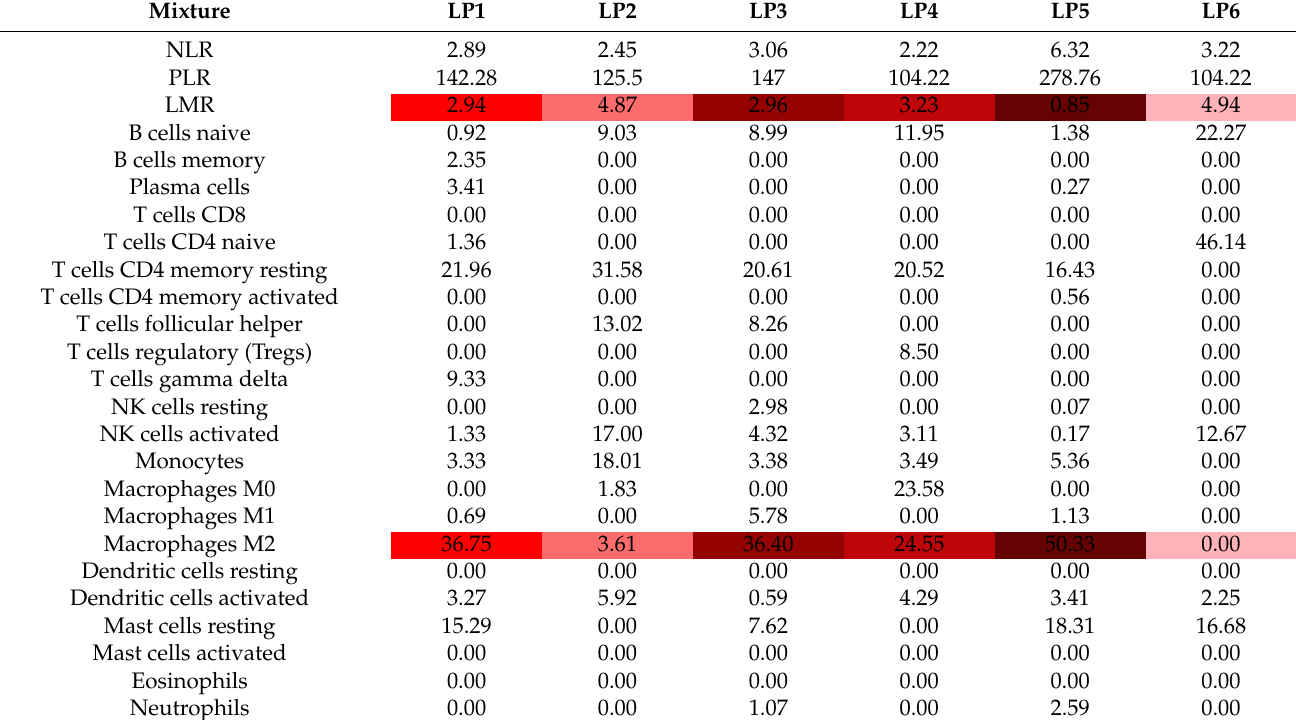
Table 3. CIBESORT analysis of immune intratumoral populations and related LMR before